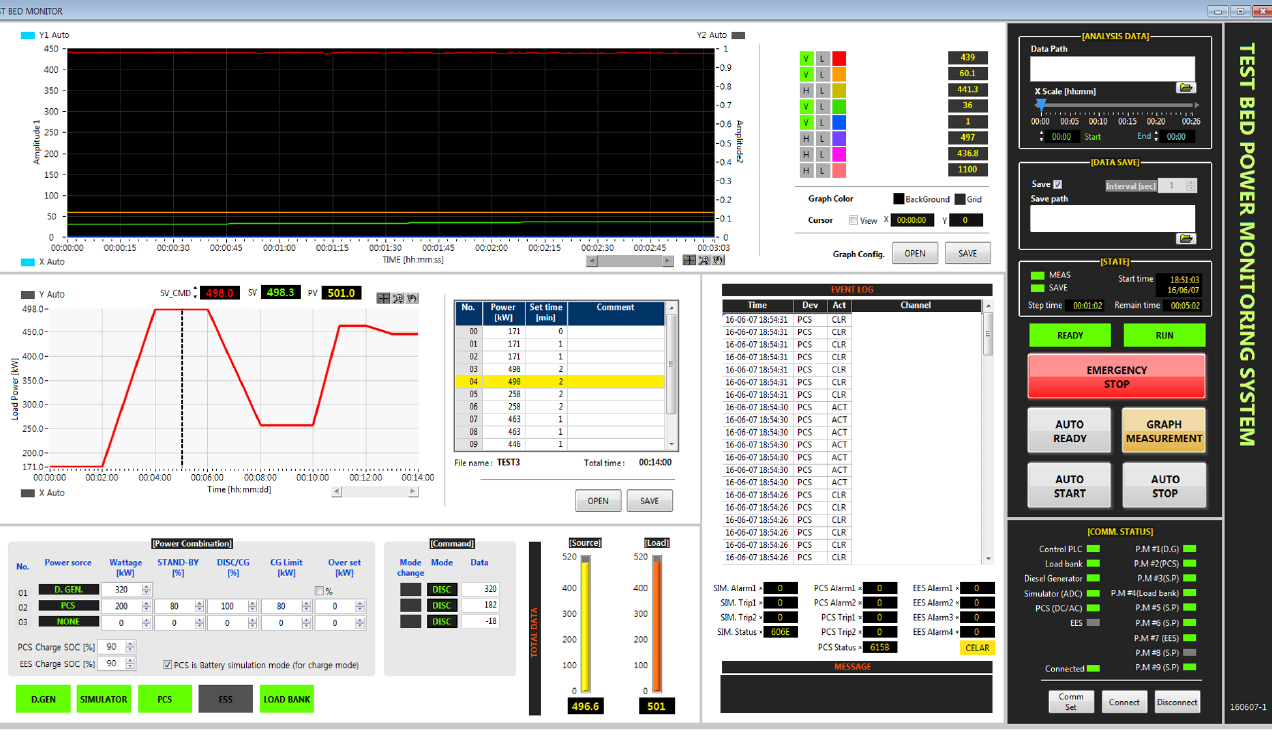
Table 5. Data acquisition list.